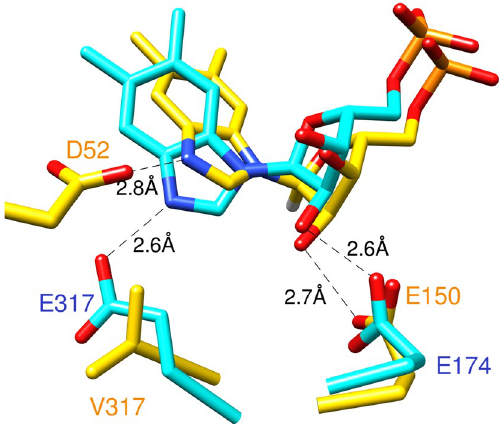
Figure 8. Active Site overlay of Mj CobT and Se CobT. In this figure, α-RP, the product of the Se CobT and Mj CobT reactions is shown in cyan and yellow, respectively. As seen in the figure, in the active site of Mj CobT, α-RP is held by interactions between the N3 atom of the imidazole ring with residue D52. Very similar interactions are observed between the N3 atom of α-RP and residue E317 of the active site of Se CobT. In both active sites α-RP is further held in position by interaction between the 2’ hydroxyl group of α-RP and either E150 (in the case of Mj CobT) or E174 (in the case of Se CobT). As shown in the figure, in Mj CobT, position 317 is occupied by a valine residue. Position 52 in Se CobT is occupied by a glycine residue. This image was generated using PyMOL 2.5